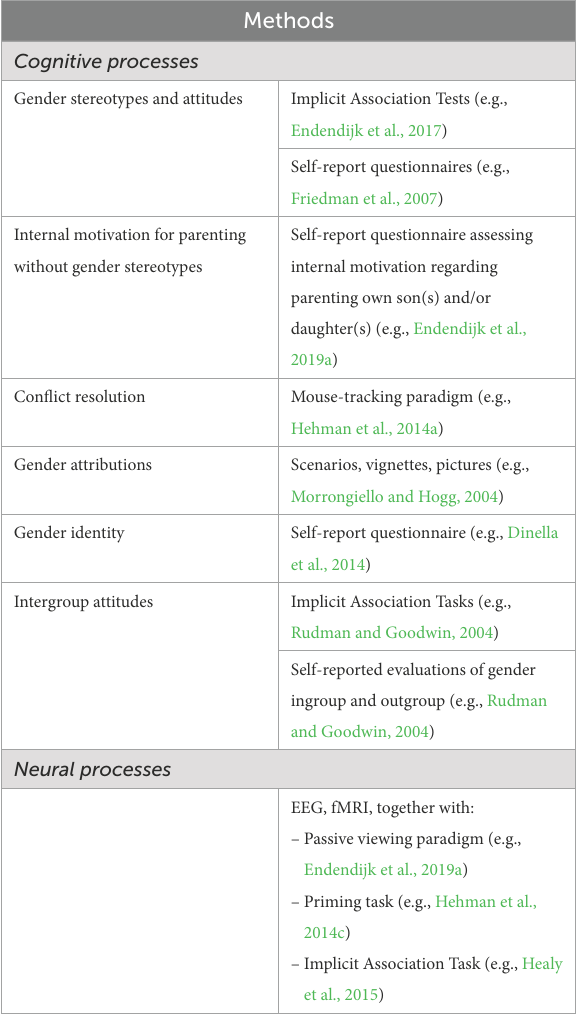
TABLE 1 Methods to assess neurocognitive processes underlying parental implicit gender